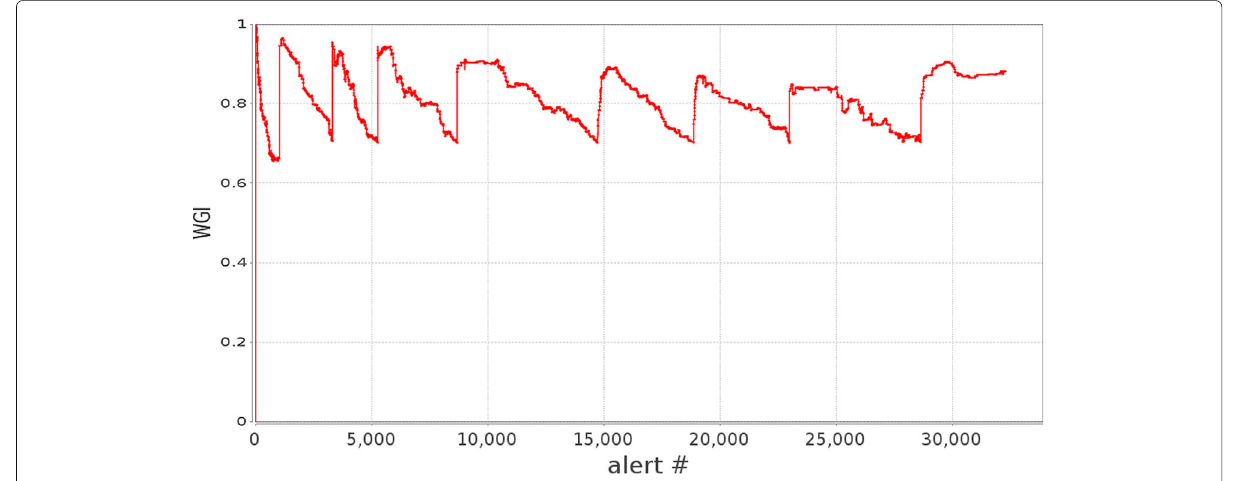
Fig. 4 WGI over iterations with shuffling